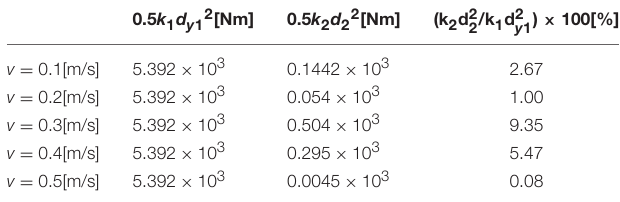
of the velocity v 1(A) of the first-story mass at Point (A) as TABLE 1 | Comparison of elastic strain energies at Point